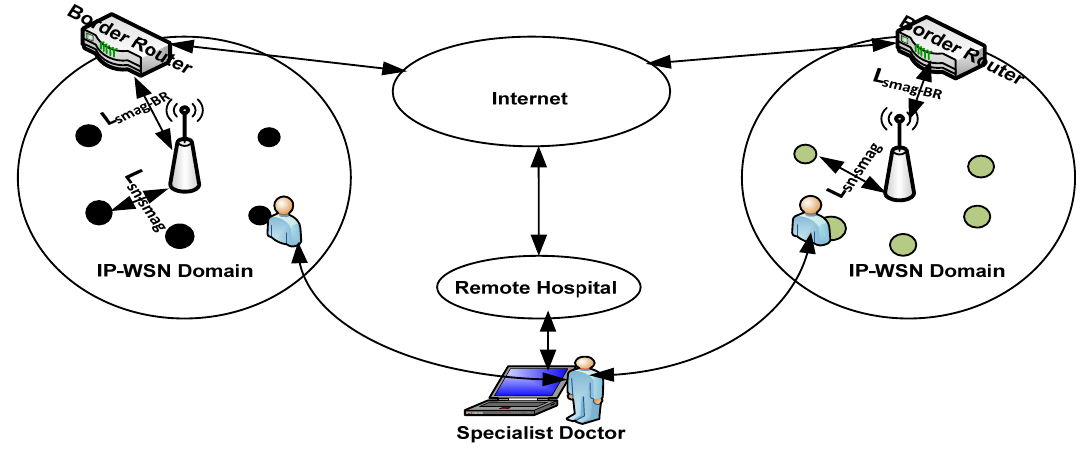
Figure 14. Analytical model for the performances